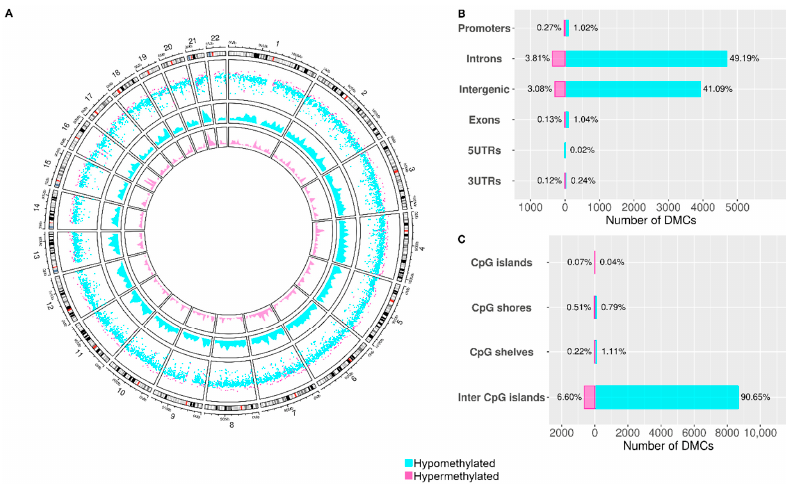
Figure 1. Genome wide methylation differences between Meniere Disease (MD) and controls. ( A ) circos plot representative of the distribution of the hypomethylated DMCs (blue) and hypermethylated DMCs (pink) per chromosome. ( B ) bar plot indicating the percentages of hypomethylated DMCs (blue) and hypermethylated DMCs (pink) according to the genetic region (intronic, exonic, intergenic, 5 ′ UTR, 3 ′ UTR, promoter); ( C ) bar plot indicating the percentages of hypomethylated DMCs (blue) and hypermethylated DMCs (pink) per island features (inter CpG island, CpG shore, CpG shelves, CpG